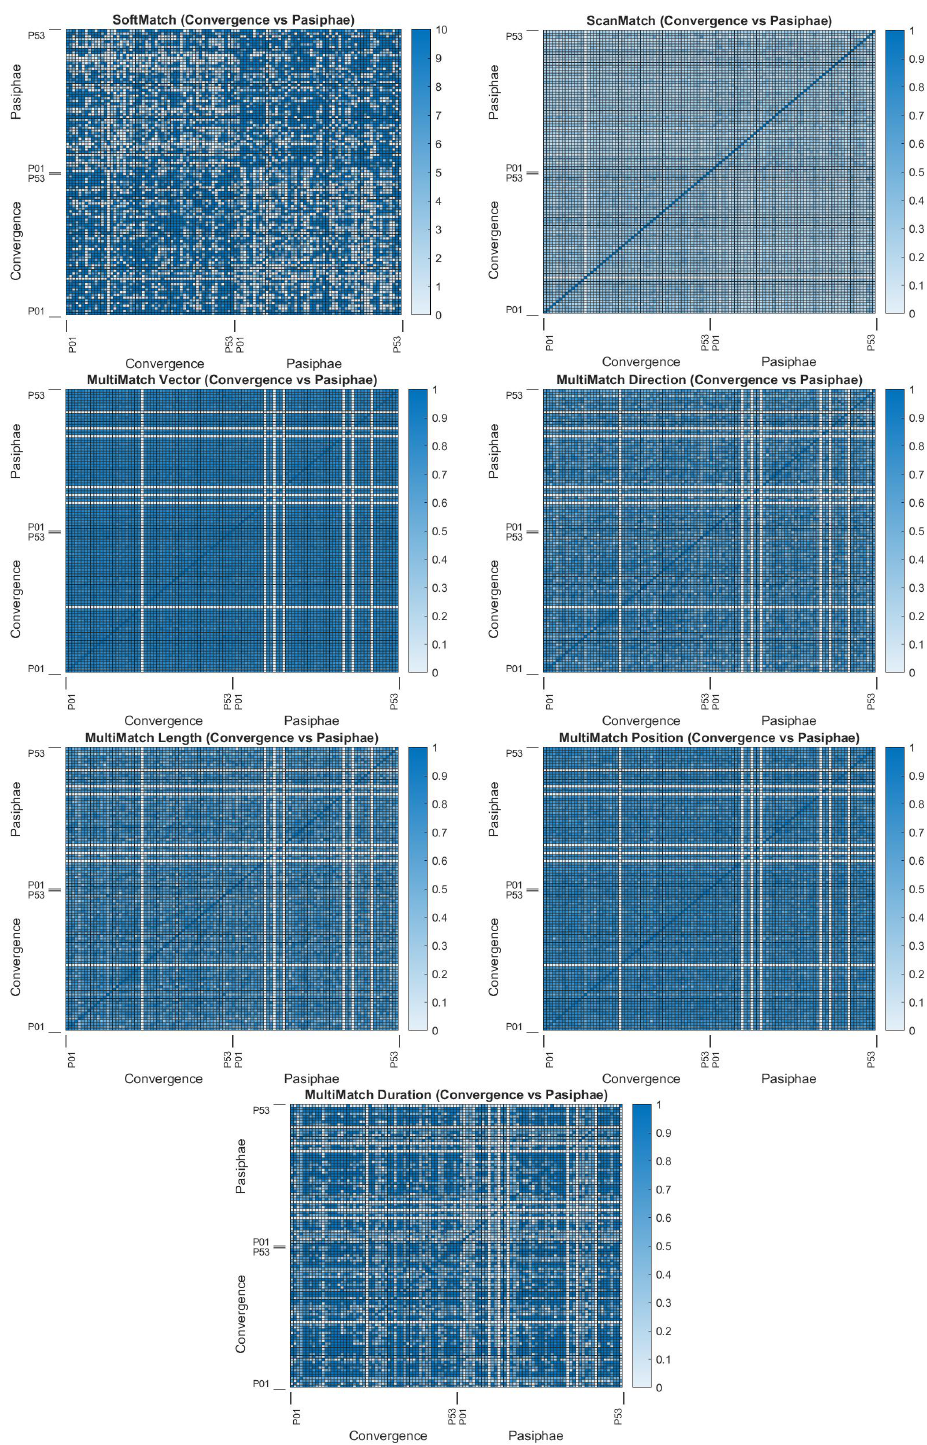
Figure A10. SoftMatch, ScanMatch, and MultiMatch heatmaps for empirical evaluation. Stimuli matched are Jackson Pollock’s Convergence (1952) and Jackson Pollock’s Pasiphae